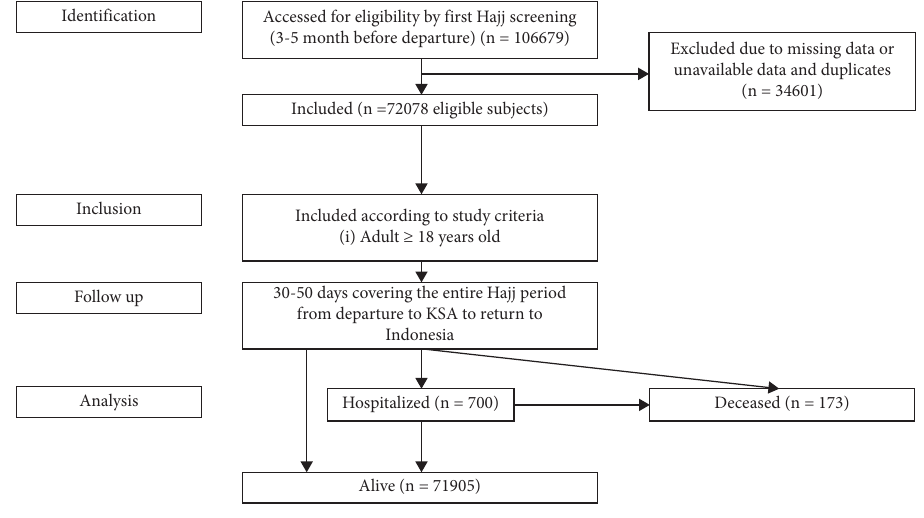
Figure 1: Flowchart of the study Table 1: Characteristics of the study population of Hajj pilgrims from East Java, Indonesia, from 2017 to 2019.